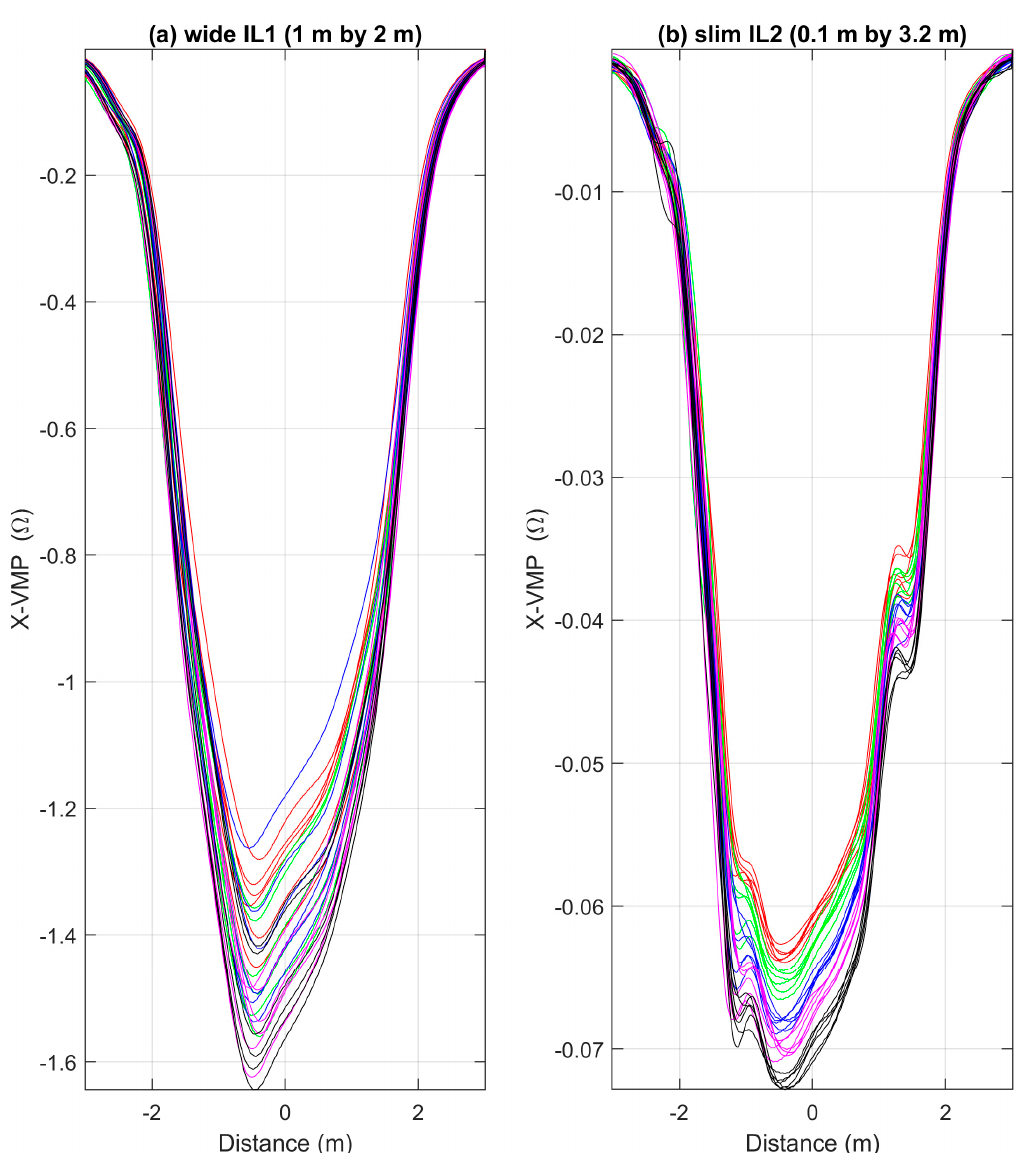
Figure A7. X-VMPs for the Hyundai ix35 test car obtained at the center excitation frequency (see Table 1, f2), the X-VMPs of red color are for unloaded test car, green for 73 kg load, blue 149 kg, magenta 225 kg and black for 306 kg load, ( a ) for a wide sensor (1 m by 2 m); ( b ) for a narrow sensor (0.1 m by 3.2 m).